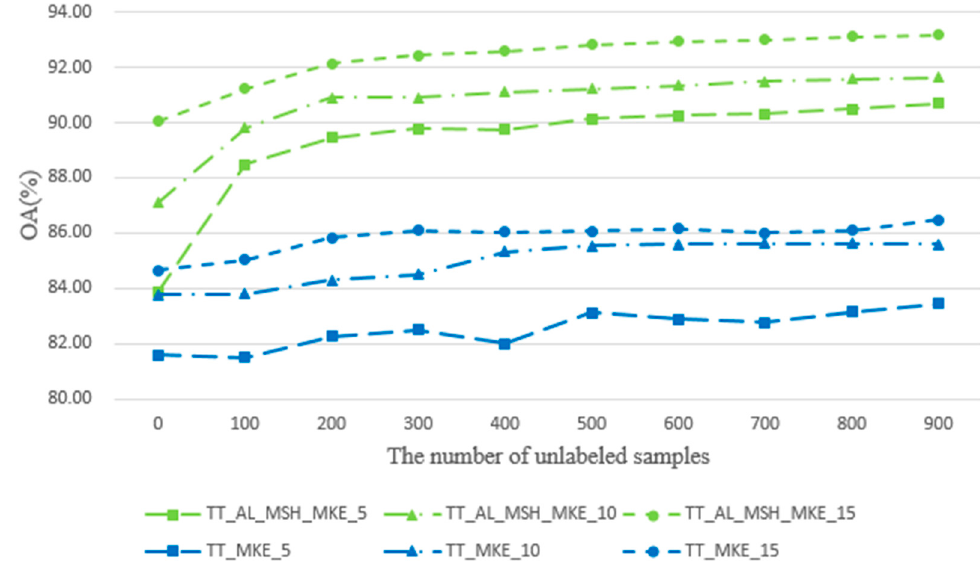
Figure 9. Overall classification accuracies obtained for the AVIRIS Salinas Valley dataset using two different techniques by using 5, 10 and 15 labeled samples per class (estimated labels of unlabeled samples were used in all the experiments).